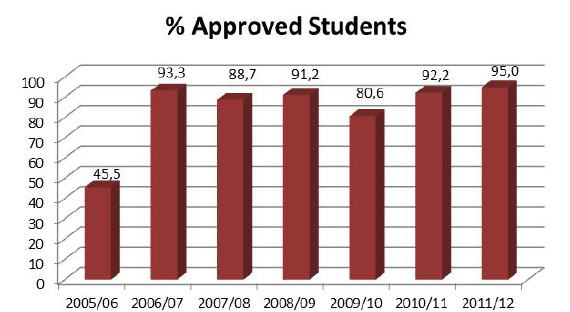
Figure 13. Percentage of approved students throughout the latest7 academic years.